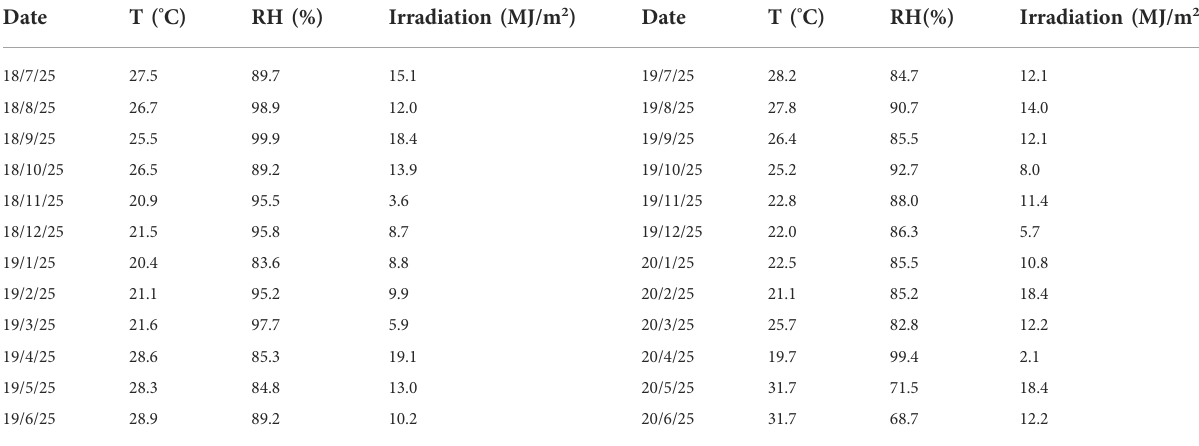
TABLE 1 Representative meteorological